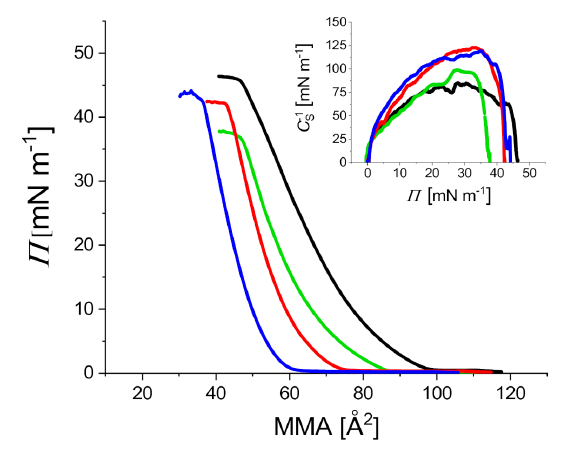
Figure 2. Compression isotherms of SM/POPC (black), SM/POPC/CHOL 10 mol% (green), SM/POPC/CHOL 30 mol% (red), and SM/POPC/CHOL 50 mol% (blue) mixed films spread on the water subphase. Inset: C S − 1 – Π dependency. T = 20 ◦ C.